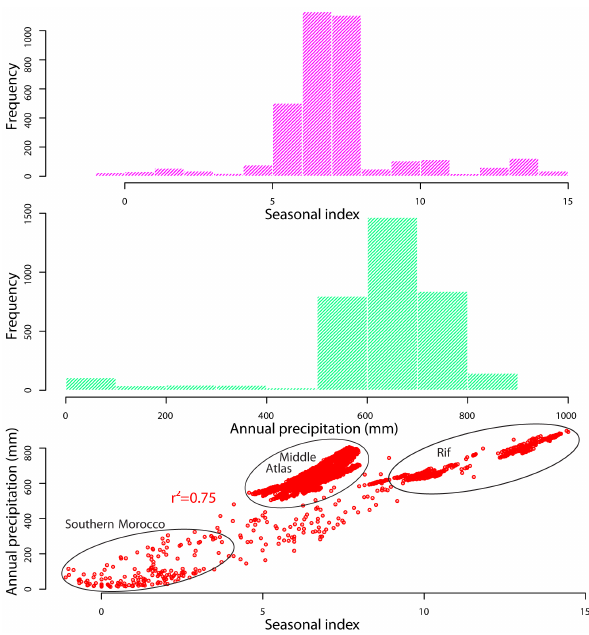
Figure 8. Modern SI (upper panel) and P ann (middle panel) from the gridded WorldClim data set (Hijmans et al., 2005) over Mo- rocco. The lower panel shows the distribution of P ann vs. SI: the lowest index occurs in southern Morocco, where P ann is lower than 200mmyr − 1 , and the highest index occurs in the high-altitudinal areas (Middle Atlas and Rif